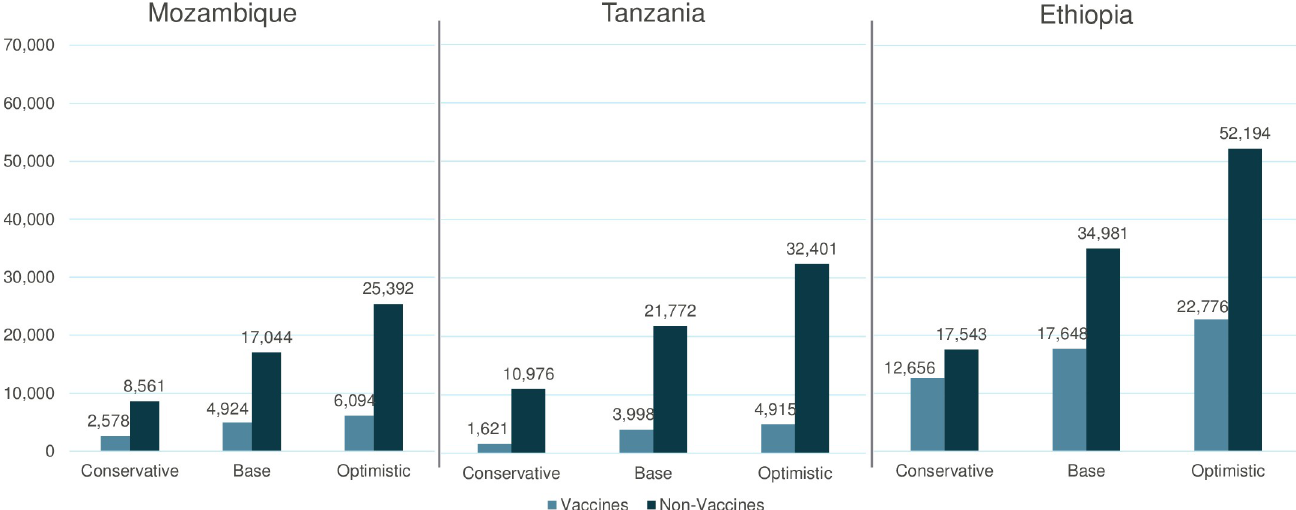
Fig 3. Total lives saved for newborns and children 0–59 months over five years when scaling up coverage of commodities across Mozambique, Tanzania, and